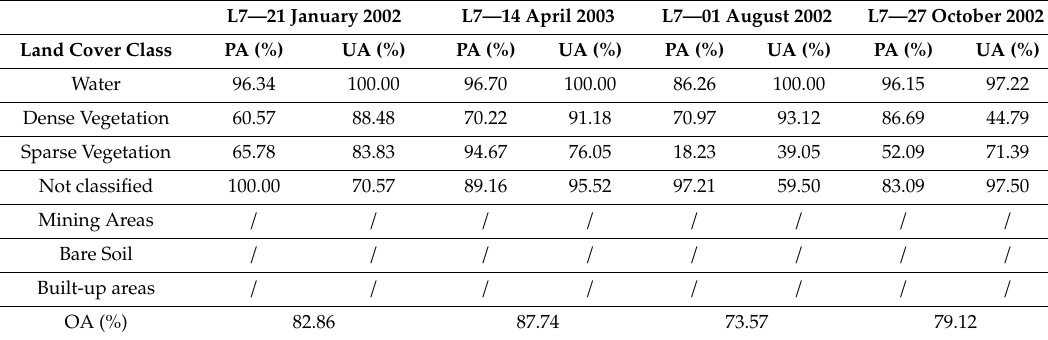
Table 7. OA, PA, and UA obtained through the application of Green Optimized Soil Adjusted Vegetation Index (GOSAVI) on the data acquired by Landsat 7 mission. UA, user’s accuracy; PA, producer’s accuracy; OA, overall accuracy.